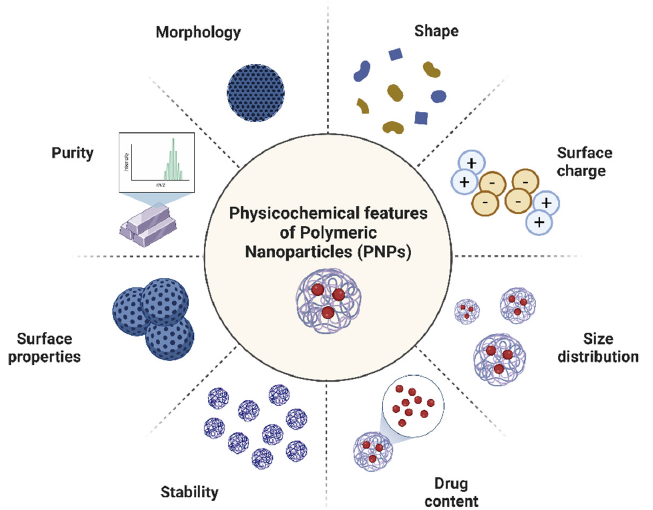
Figure 1. Graphical description of some of the pivotal physicochemical features of polymeric nanoparticles. The characterization process of nanoparticles requires a series of analyses which allow us to know the chemical composition, the surface characteristics, the dimension and the stability. All this information will be essential for the subsequent loading and transport of molecular